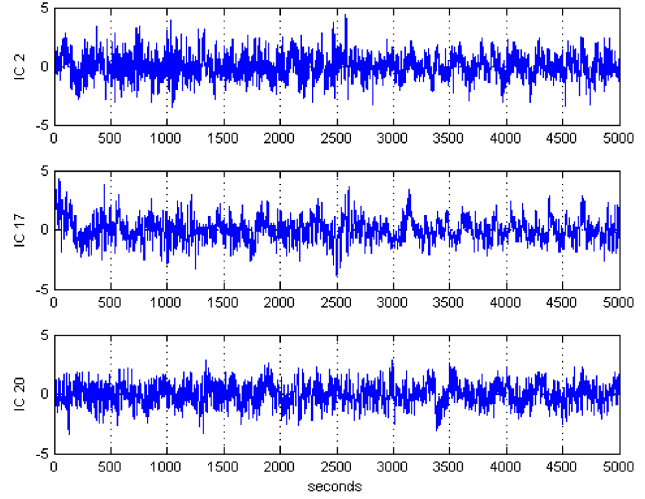
Figure 6. Artifactual components successfully detected by kurtosis for the first control subject.